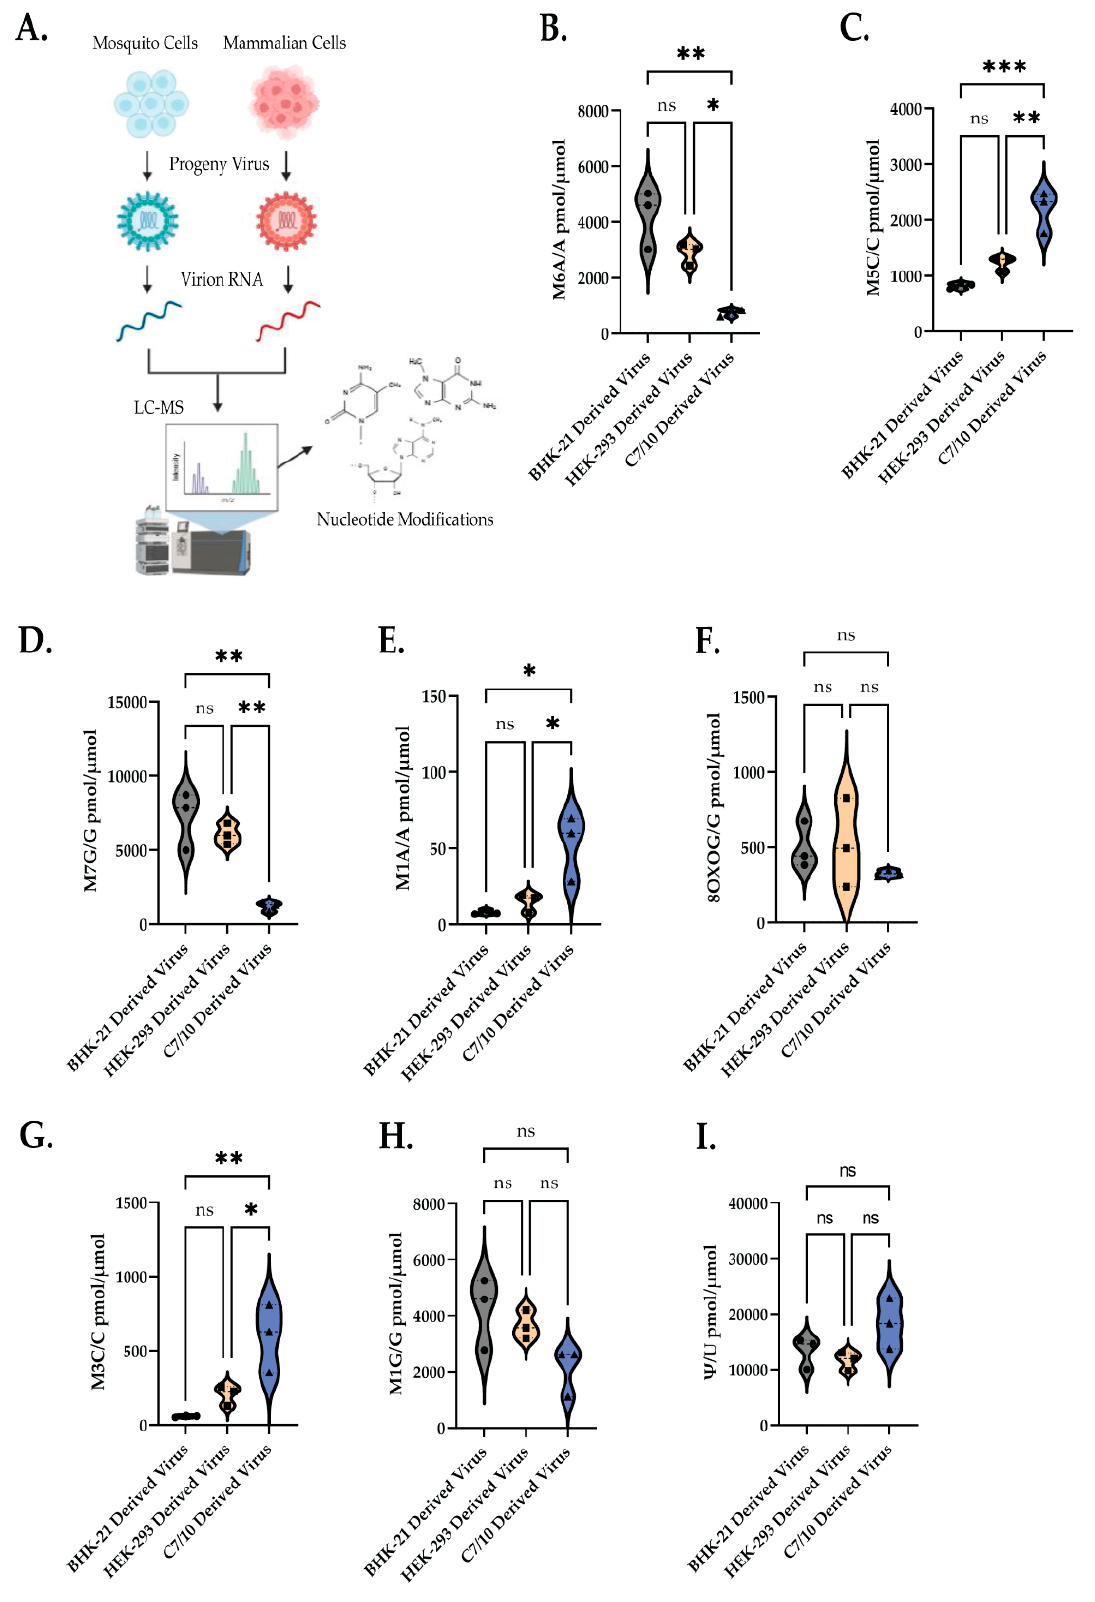
Figure 4. LC/MS analysis reveals species specific modifications acquired by SINV. ( A ) Schematic of liquid chromatography in tandem with mass spectrometry experiment. ( B ) Normalized 6-methyl adenosine (m6A) content of RNA isolated from BHK-21-, HEK-293-, and C7/10-derived